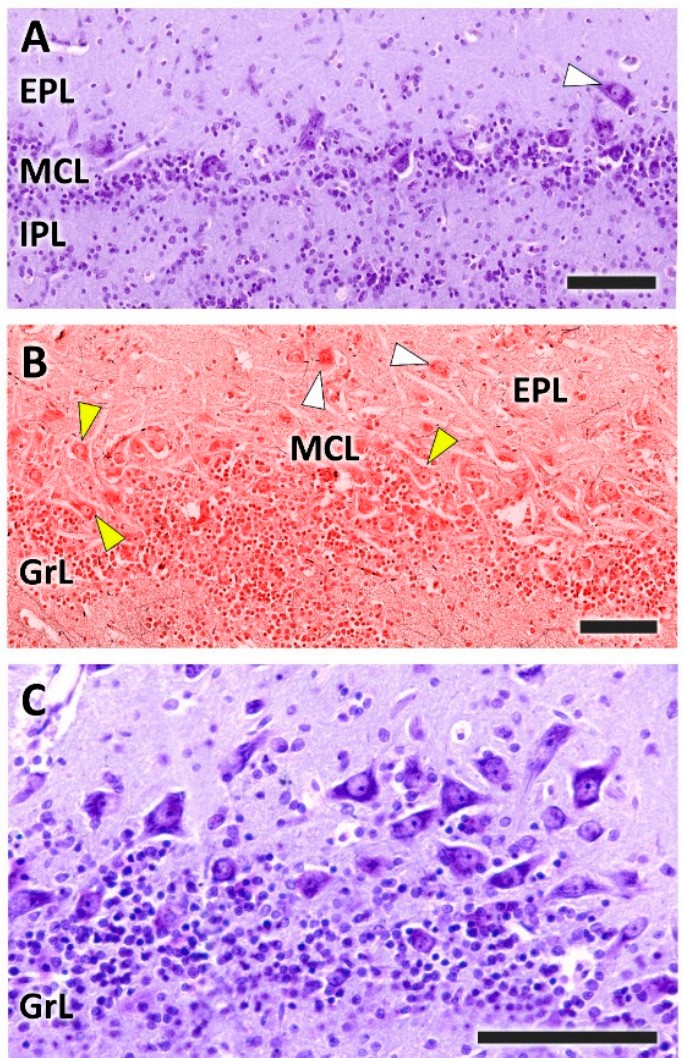
Figure 5. Histological study of the mitral cell layer of the olfactory bulb of the dog. ( A , B ) Nissl and Tolivia staining, respectively, of the mitral cell layer (MCL) showing typical mitral cells (yellow arrowheads) and deep tufted cells (white arrowheads) scattered along the boundaries between the external (EPL) and internal plexiform layers (IPL). ( B , C ) Sagittal section of the OB reveals a higher density of mitral cells, which are mitered or triangular in shape. Tolivia and Nissl staining, respectively. Scale bars: ( A , B ): 250 µ m; ( C ): 100 µ m.